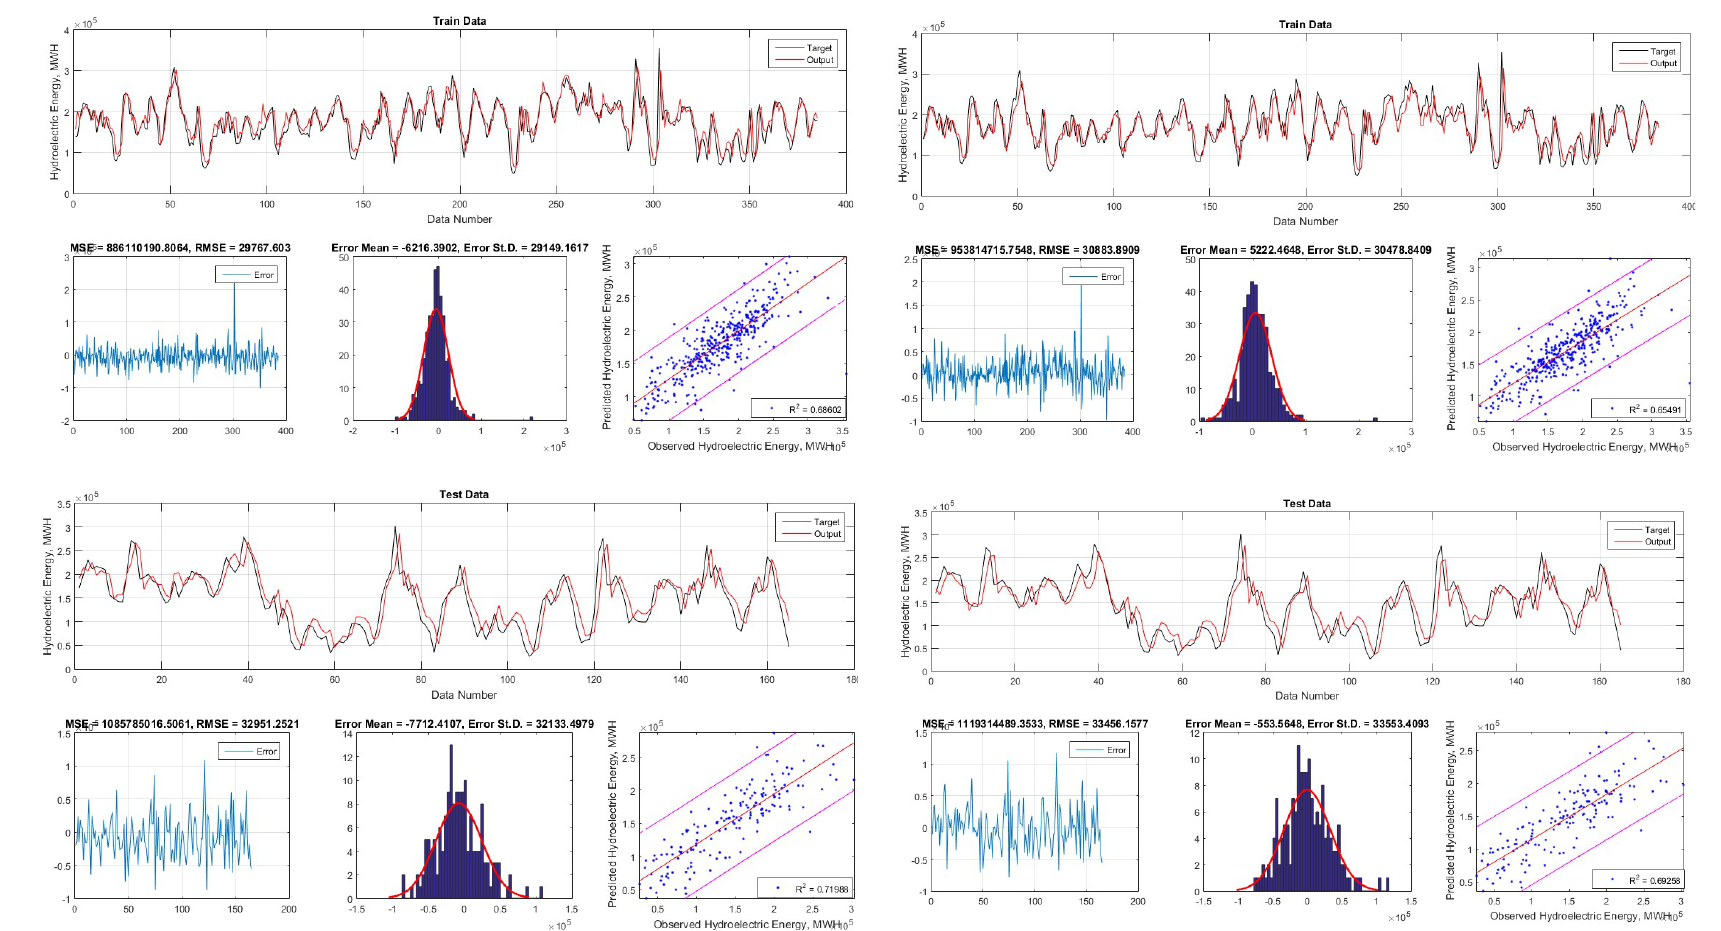
Figure 6. Observed and forecasted time series of hydropower generation using ANFIS.